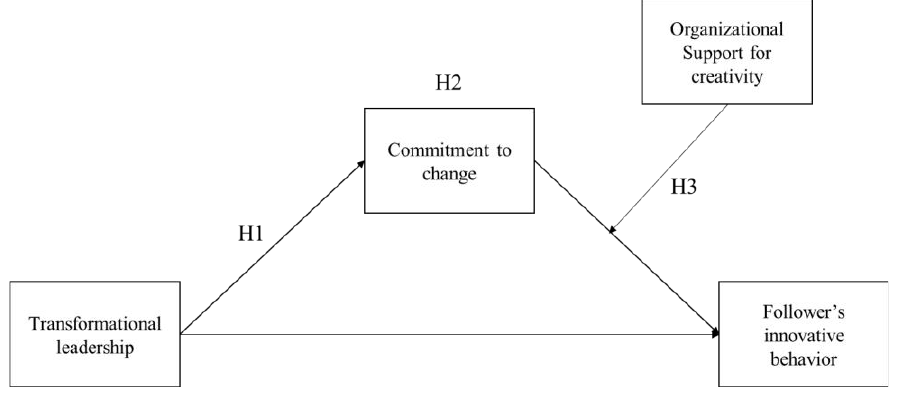
Figure 1. Theoretical research model (made by authors,